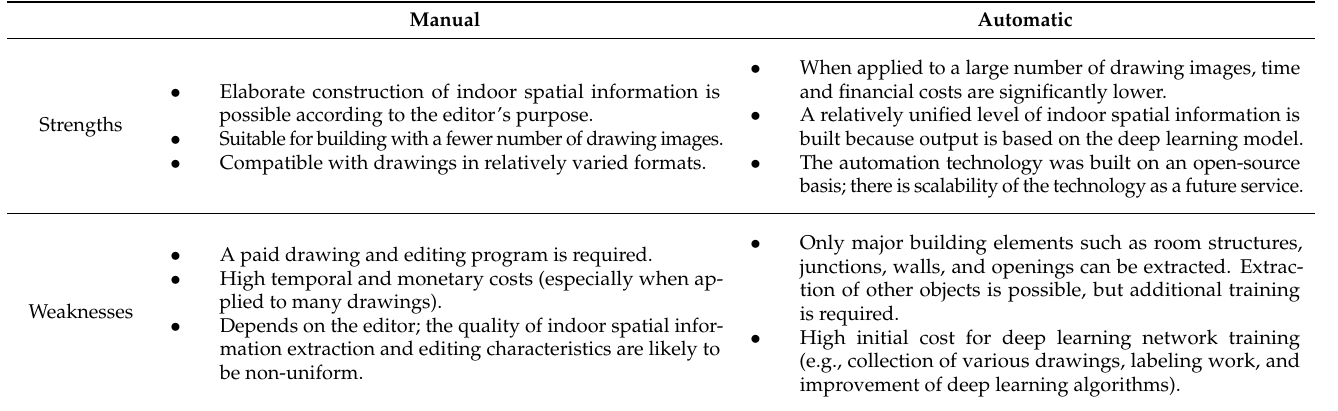
Table 1. Strengths and weaknesses of manual and automatic approach.